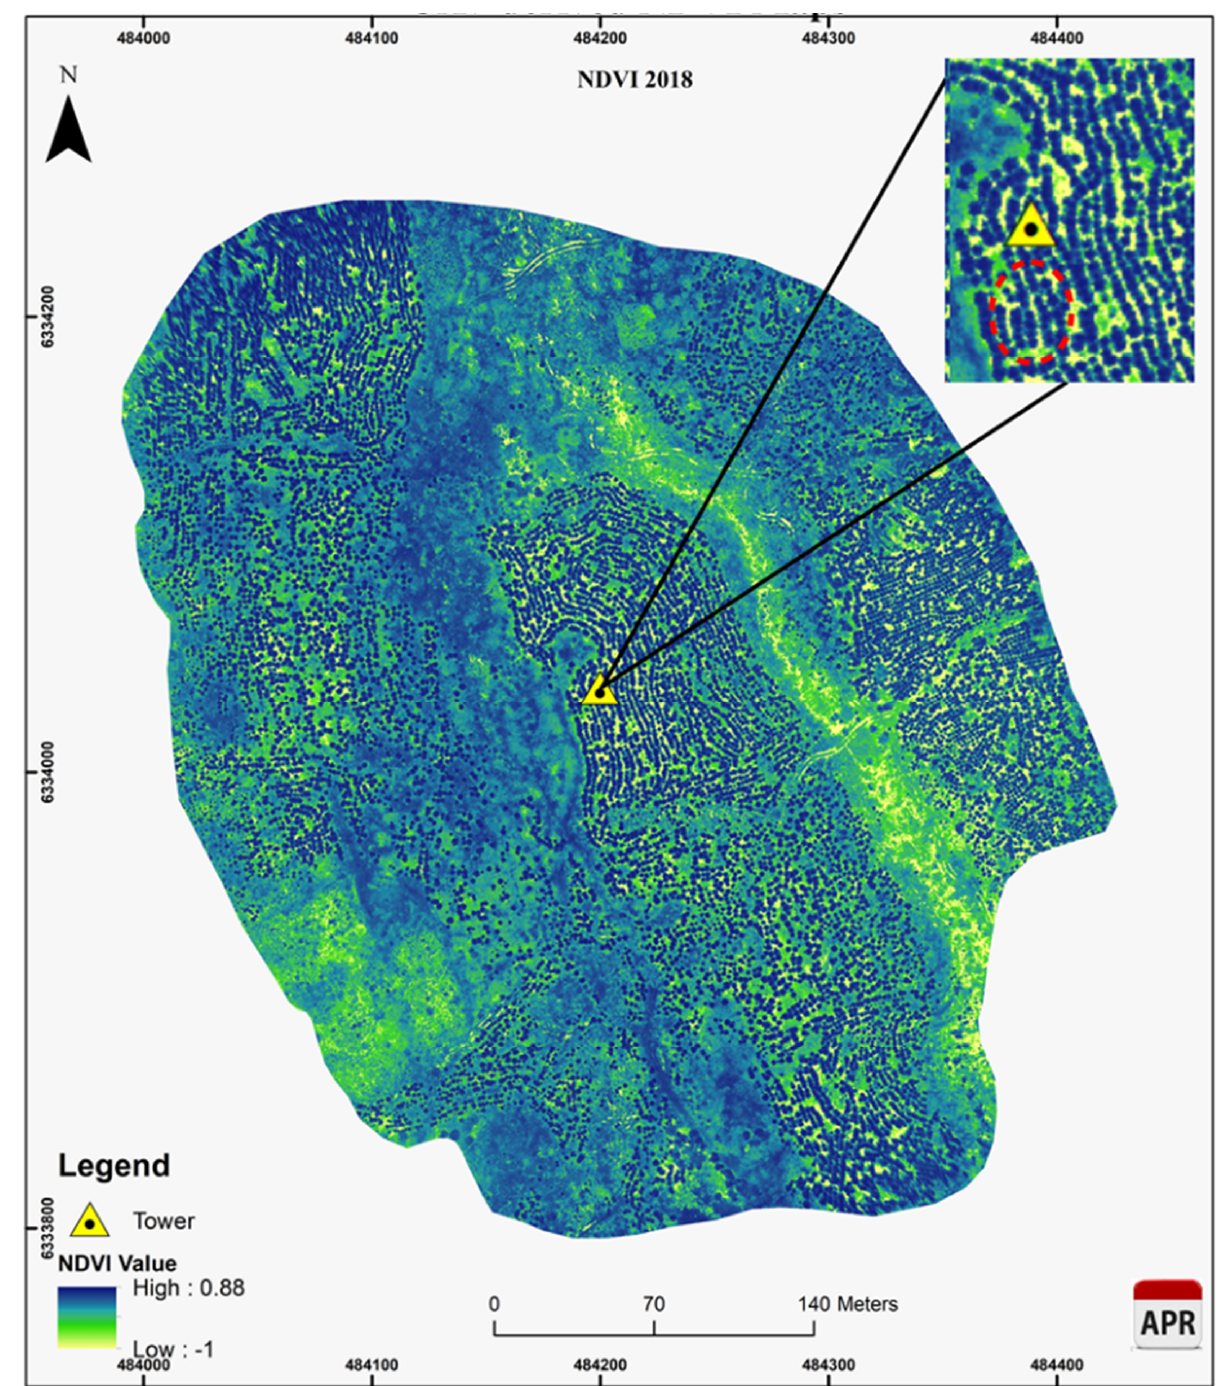
Figure 6. NDVI map of flight conducted in April 2018. Yellow marker represents fixed tower with PhenoCam and SRS sensors. Dashed ellipse (red) refers to the projected spectral sensor footprint.